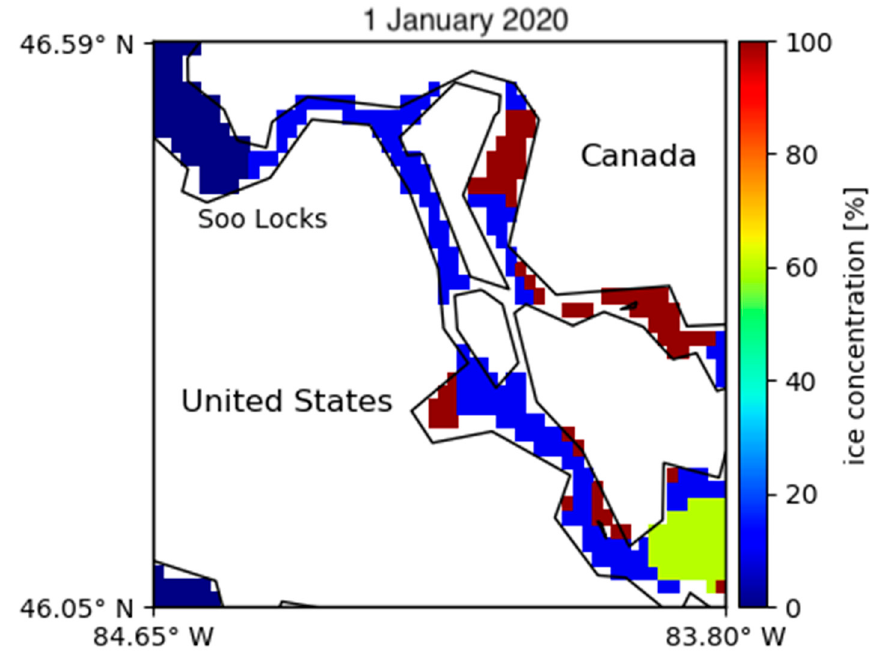
Figure 4. Spatial map of average ice concentration of St. Marys River.